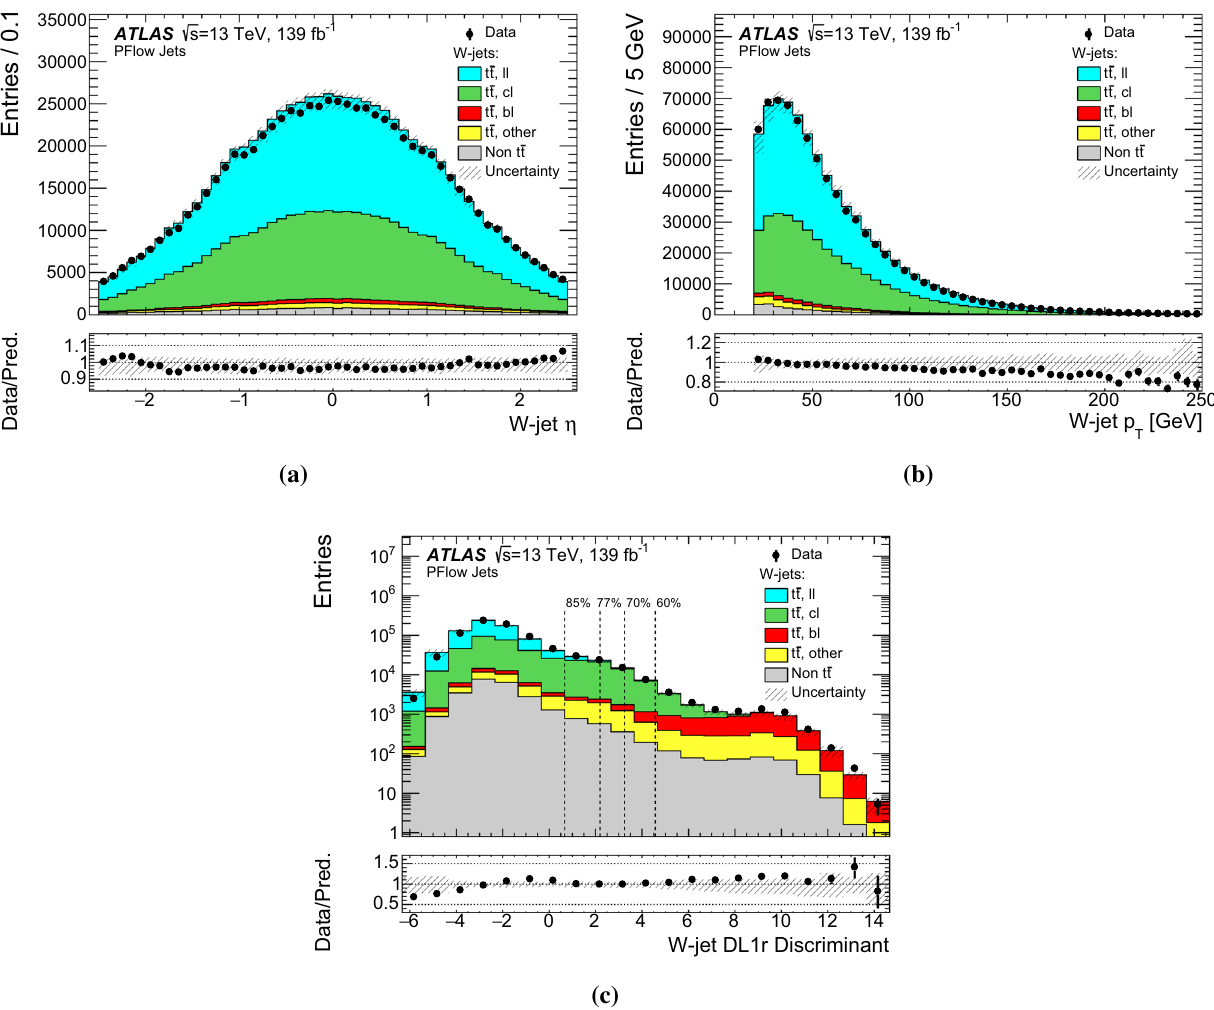
Fig. 2 Distributions of a η , b p T and c the DL1r discriminant for the particle-flow jets that are associated with the W boson decay by the likelihood-based t ¯ t event reconstruction algorithm ( W -jets). The t ¯ t simulation is split according to the flavours of the W -jets ( ll , cl , bl and other). The (mis)tagging efficiency scale factors have not been applied